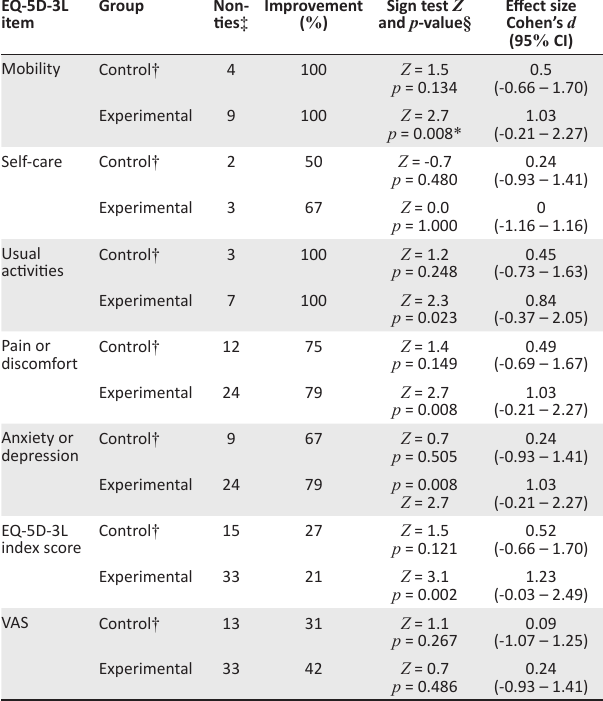
TABLE 4: Within-group comparison of measures at baseline and at 6 weeks. EQ-5D-3L